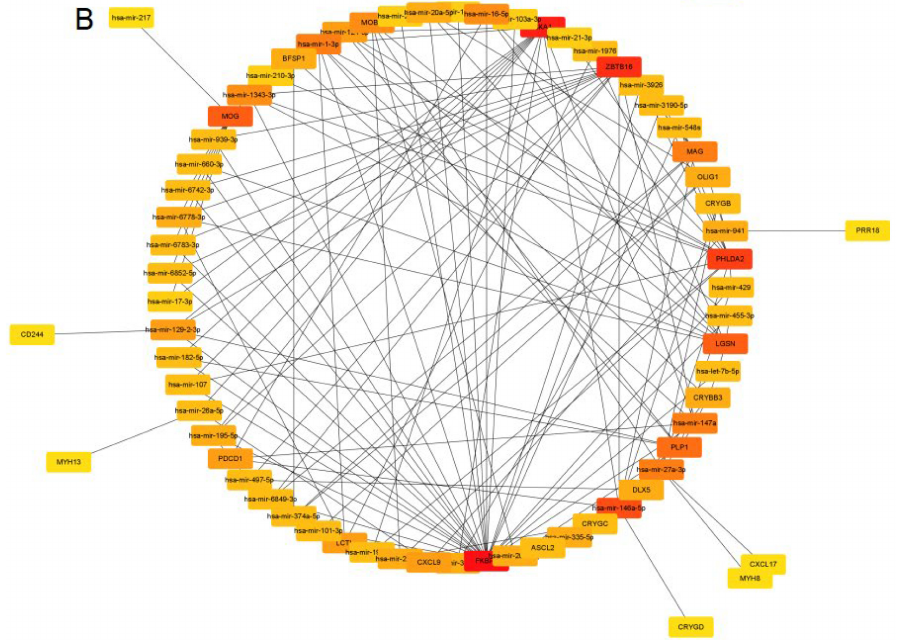
Figure 5. Construction of miRNA–mRNA networks. ( A ). miRNA–mRNA network for up-regulating DEGs with 15 miRNAs. ( B ). miRNA–mRNA network for down-regulating DEGs with 43 miRNAs.